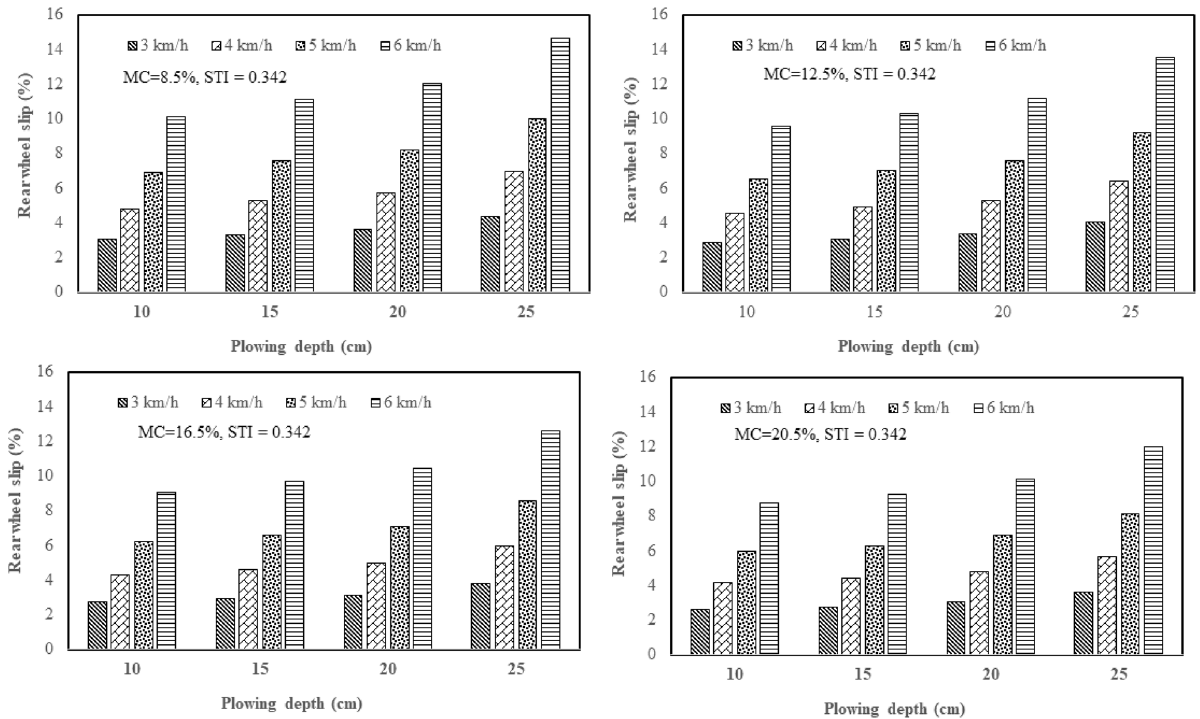
Figure 5. Effect of plowing speed and depth on the tractor rear wheel slip in 2WD mode at different levels of soil moisture content during plowing process by chisel plow in soil with a texture index of 0.342.